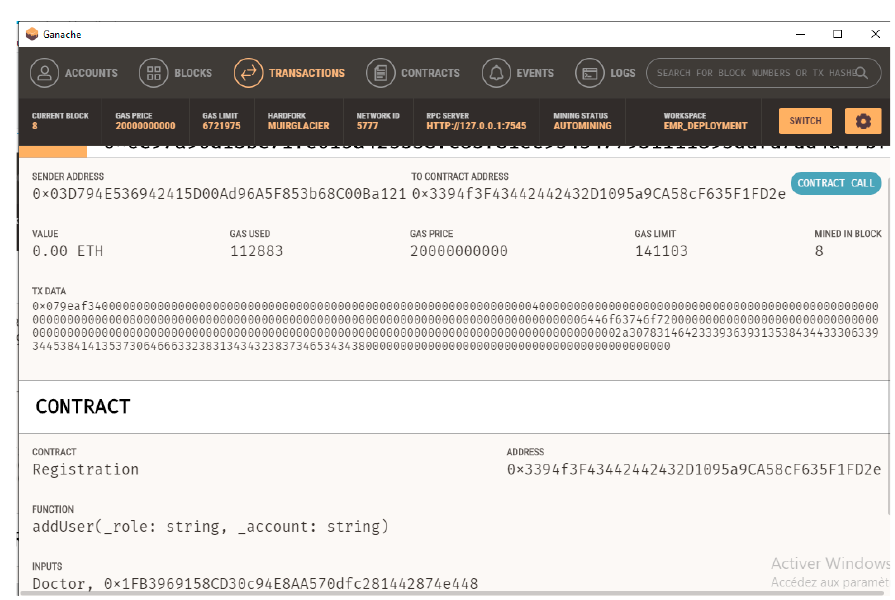
Figure 10. Registration smart contract deployment.